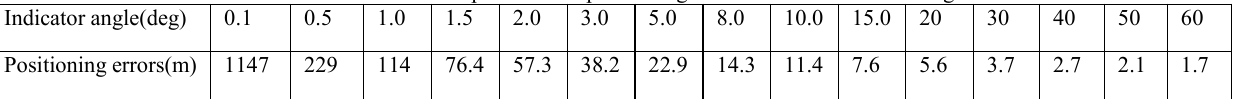
Table 1. is statistics for optical stereo positioning errors and their indicator